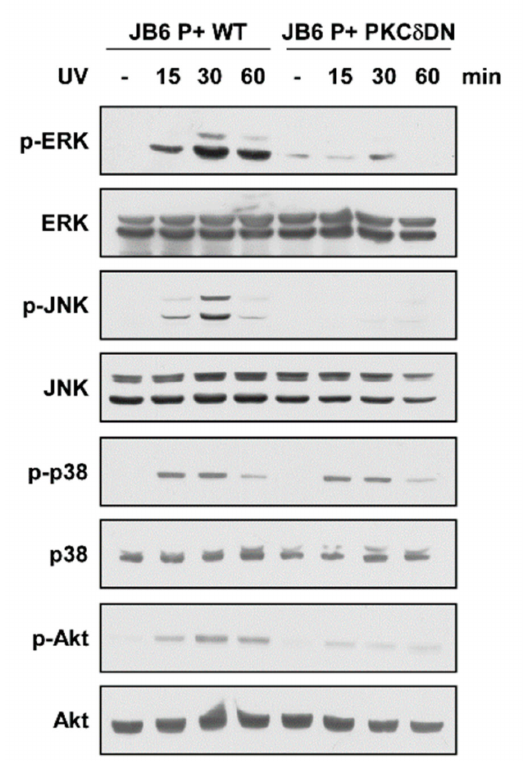
Figure 4. E ff ect of PKC δ on UV-induced signaling pathways. Cells were transfected with either a mock vector or a dominant-negative mutant (DN) of the PKC δ . Following incubation, proteins were extracted with cell lysis bu ff er. Protein levels of phosphorylated and total ERK, JNK, p38, and Akt were examined by immunoblot. Immunoblots are representative images of three independent